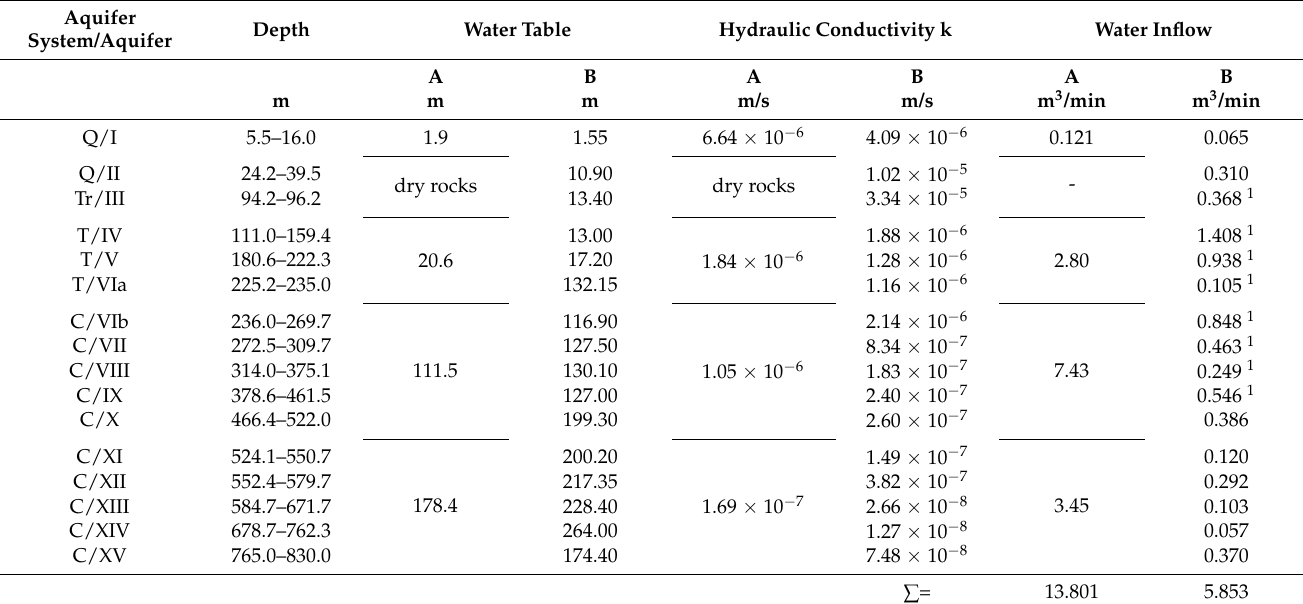
Table 1. Results of hydrogeological investigation in boreholes A and